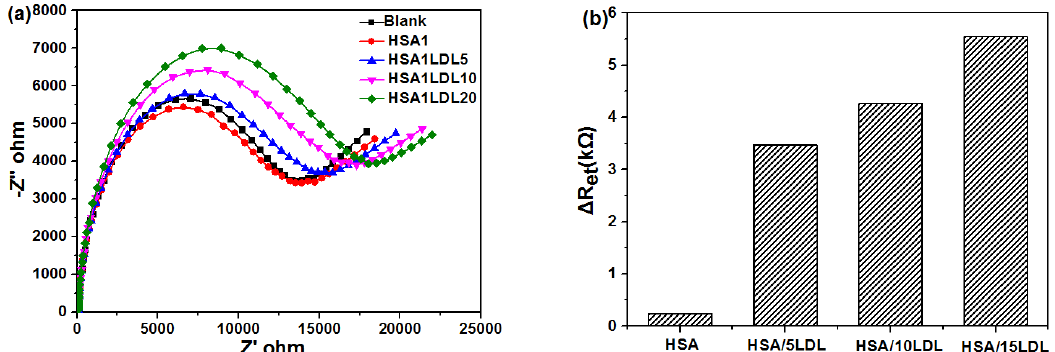
Figure 6. Faradaic impedance spectra that corresponded to the fabricated sensor at 25 °C, before and after incubating with same concentrations of ( a ) HDL, 20 μ g/mL or ( b ) LDL, 20 μ g/mL in PBS (50 mM, pH 7.0) solution containing 0.1 M KCl and 5 mM